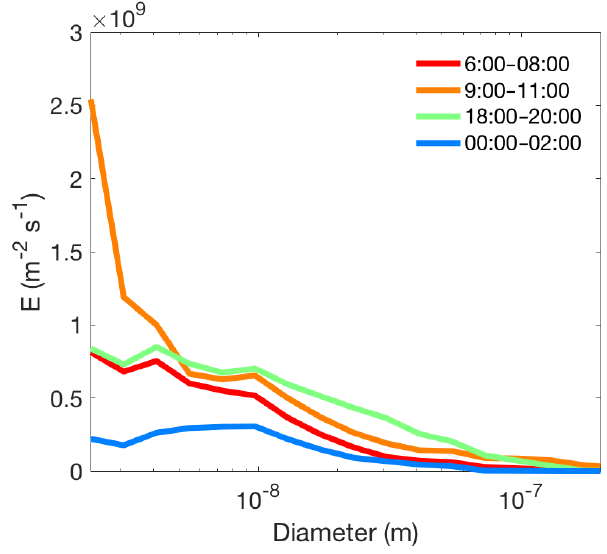
Figure 6. Average particle number emission size distributions on non-NPF event days at different times. For the size distributions depicted on a logarithmic scale, see Fig. A3 in the